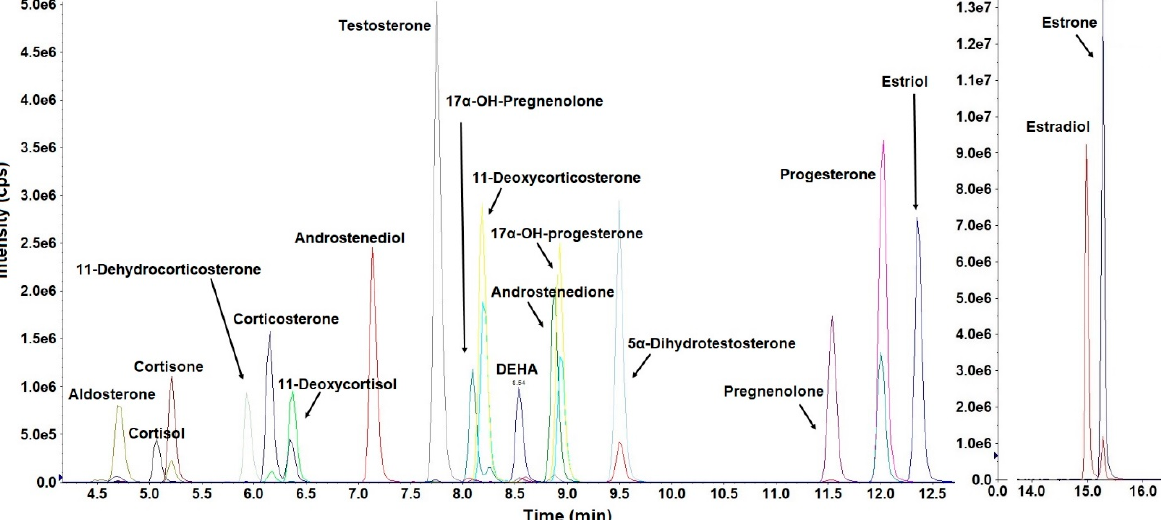
Figure 3. Representative LC-MS/MS chromatograms of 19 steroid hormones in solvent. Concentra- tions of the target analytes were 100 ng/mL; Injection volume was 10 µL; estrone, estradiol, and estriol were derivatized using dansyl chloride. Estrone and estradiol were shown separately because of their significantly higher intensities than the other analytes.